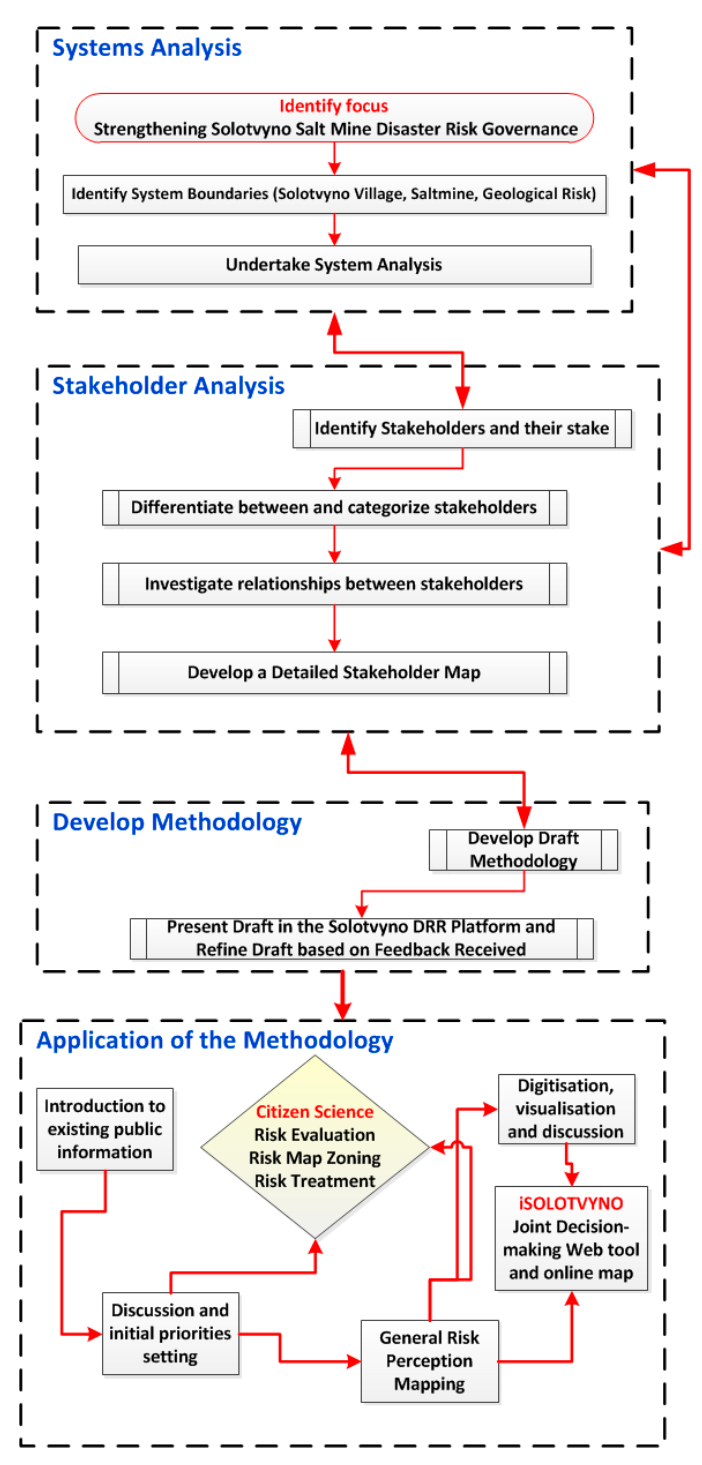
Figure 4. Schematic representation of critical methodological steps necessary for system and stakeholder analysis and the development and application of the methodology for Participatory GIS Risk Mapping and Citizen Science for Solotvyno Salt Mines. The methodology comprises a six-stage process. The process is iterative and flexible enough to be changed based on the local circumstances and agreements made with the stakeholders. The system and stakeholder analysis are modified from Reed (2009, 1947) schematic representation of the critical steps for stakeholder analysis [54]. The Methodology for Participatory GIS Risk Mapping and Citizen Science for Solotvyno Salt Mines is adjusted from Haklay (2018, 3) PGIS and CS methodology